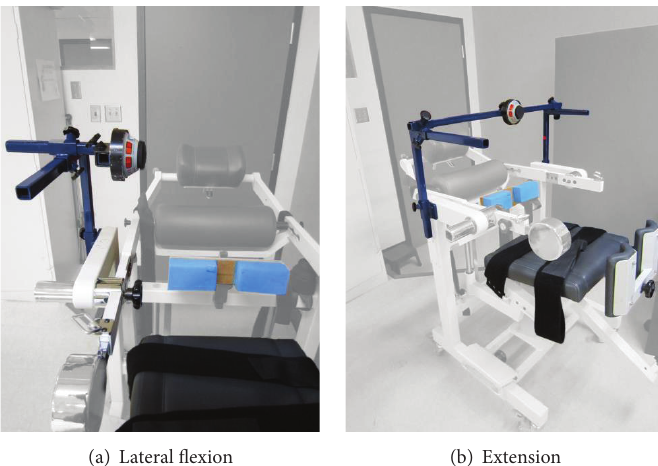
Figure 2: Schematic representation of the structure used to fix and stabilize the hand-held dynamometer when testing lateral flexion (a) and extension (b) of the